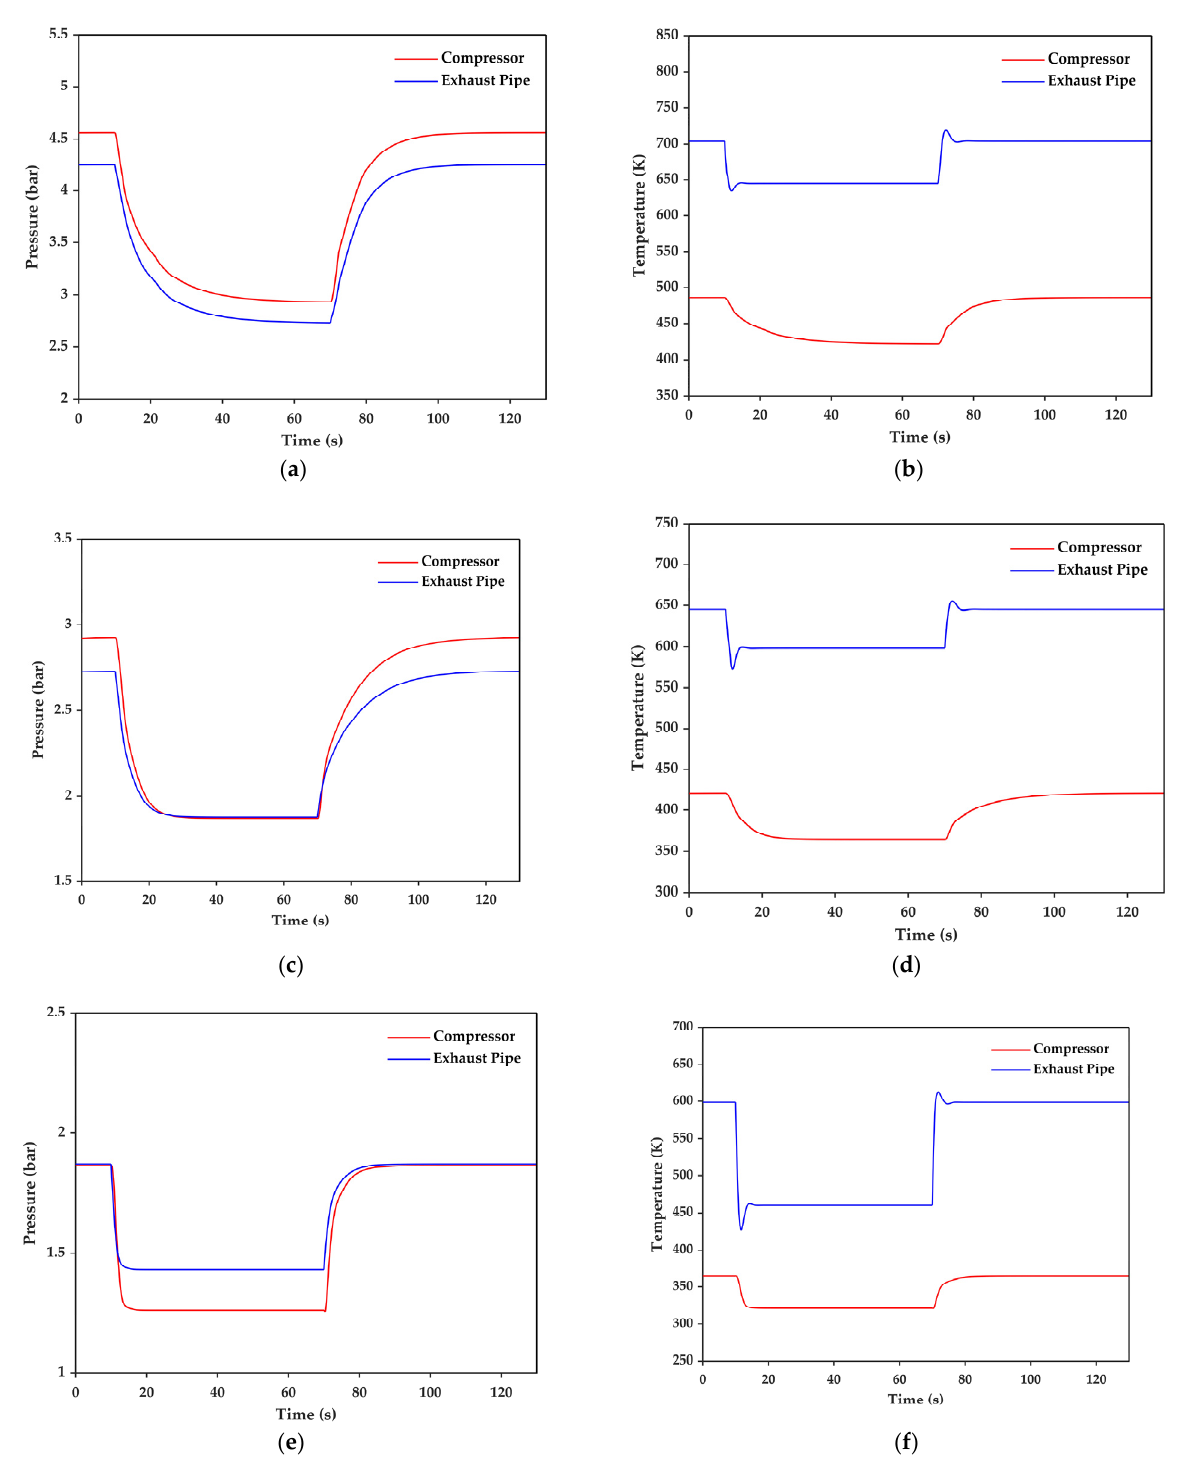
Figure 5. Transient response of the engine performance parameters with the change of setting speed: ( a ) pressure curves of the compressor and the exhaust pipe in case (1), ( b ) temperature curves of the compressor and the exhaust pipe in case (1), ( c ) pressure curves of the compressor and the exhaust pipe in case (2), ( d ) temperature curves of the compressor and the exhaust pipe in case (2), ( e ) pressure curves of the compressor and the exhaust pipe in case (3) and ( f ) temperature curves of the compressor and the exhaust pipe in case (3).